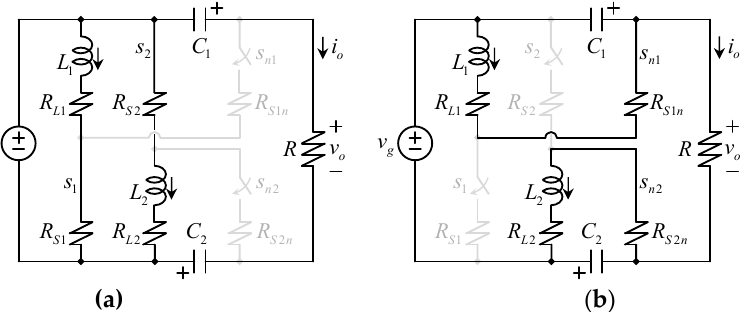
Figure 8. Equivalent circuits according to the switching state. Proposed circuit with series losses through inductors and transistors ( a ) when transistors are closed ( b ) when transistors are open. According to those equivalent circuits (see Figure 8), the dynamic equations for in- Equations (25) and (26) contain the voltage drops in ESR of elements in series with ductors (in other words, the average voltage across inductors L 1 and L 2 during one switch- inductors when they are charging and discharging. Similarly, the averaging technique can ing cycle) can be expressed as (25) and (26), respectively. be applied to the current through capacitors. The average current through capacitors C 1 and C 2 can be expressed as (27) and (28),